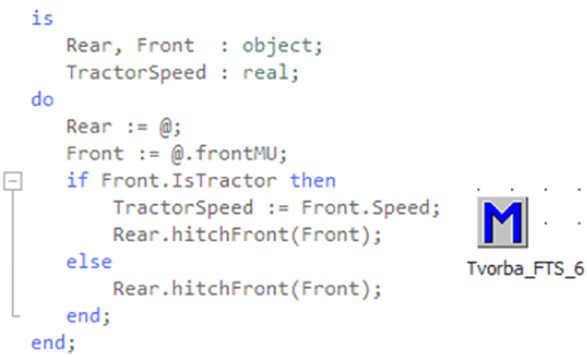
Figure 6: Method function in the simulation program.